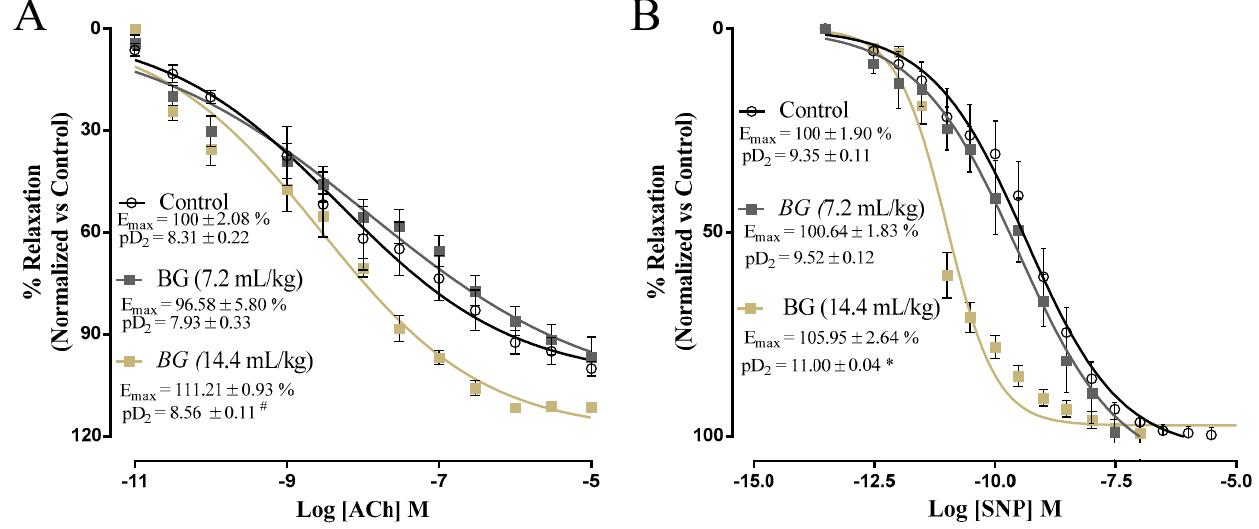
Figure 4. Effects of Baru almond oil ( Dipteryx alata Vog . ) on endothelial function in male rats. Eval- uation of vascular reactivity in aorta artery rings. Concentration–response curve for acetylcholine (Ach, A ) in rings with functional endothelium and dose–response curve for sodium nitroprusside (SNP, B ) in rings without functional endothelium. * p -value < 0.05 vs. control group. # p -value < 0.05 vs. BG 7.2 mL/kg group.